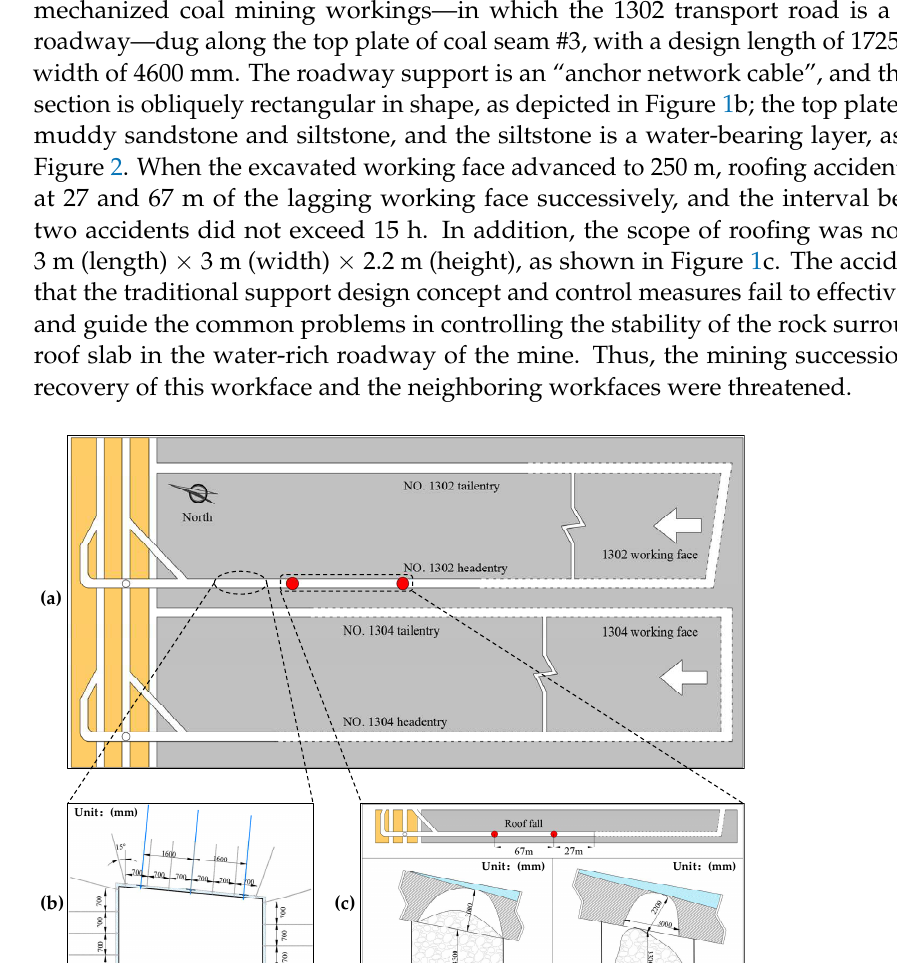
Figure 2. Description of coal and rock seams. 3. Weakening Mechanism of Strength of Rock Surrounding Water-Rich Roadway Top Slab 3.1. Specimen Preparation The rock sample used for the test was taken from the muddy sandstone at the roof of the 1302 haul road in the mine. It was sealed by wrapping with cling film to prevent the specimen from weathering. According to the “Regulation for testing the physical and me- chanical properties of rock” (DZ/T 0276.18-2015 [25]), the rock was processed into stand- ard rectangular rock samples of dimensions 50 mm × 50 mm × 100 mm; the adjacent faces of the rock samples were perpendicular to each other, as required, with a maximum de- viation of not more than 0.25°; the non-parallelism between the opposite faces was less than 0.1 mm. In total, 24 rectangular rock samples were processed. The finished samples were dried and weighed, and the drying temperature and time were set to 105 °C and 24 h, respectively, as shown in Figure 3. To reduce the influence of sample dispersion on the